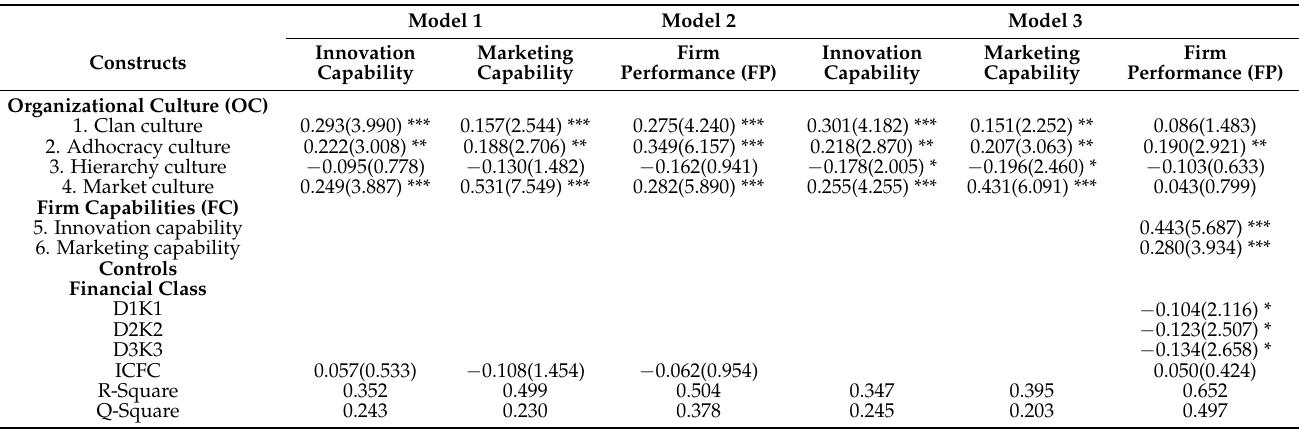
Table 4. Standardized path estimates with bootstrapping ( t